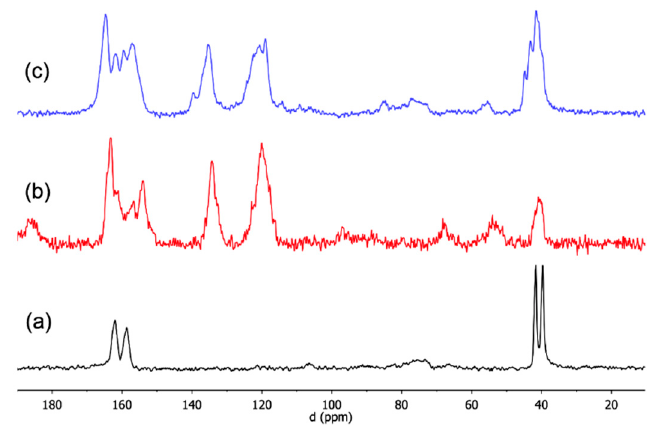
Figure 9. 13 C-CPMAS ( a ) pristine HMfCl, ( b ) H 2 Mf(HpOXA) 2 · 4W organic salt, and ( c ) H 2 Mf(HpOXA) 2 microcrystalline powder.